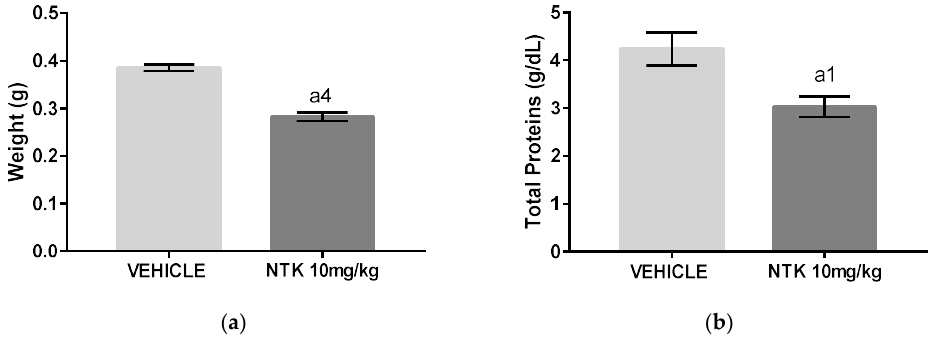
Figure 8. The e ff ects of NTK treatment on cotton pellet-induced granuloma in mice. ( a ) Final weight of the granuloma. ( b ) Protein concentration in the homogenates. a4 = p < 0.0001 vs. saline and a1 = p < 0.05 vs. saline. Statistical significance was determined with T